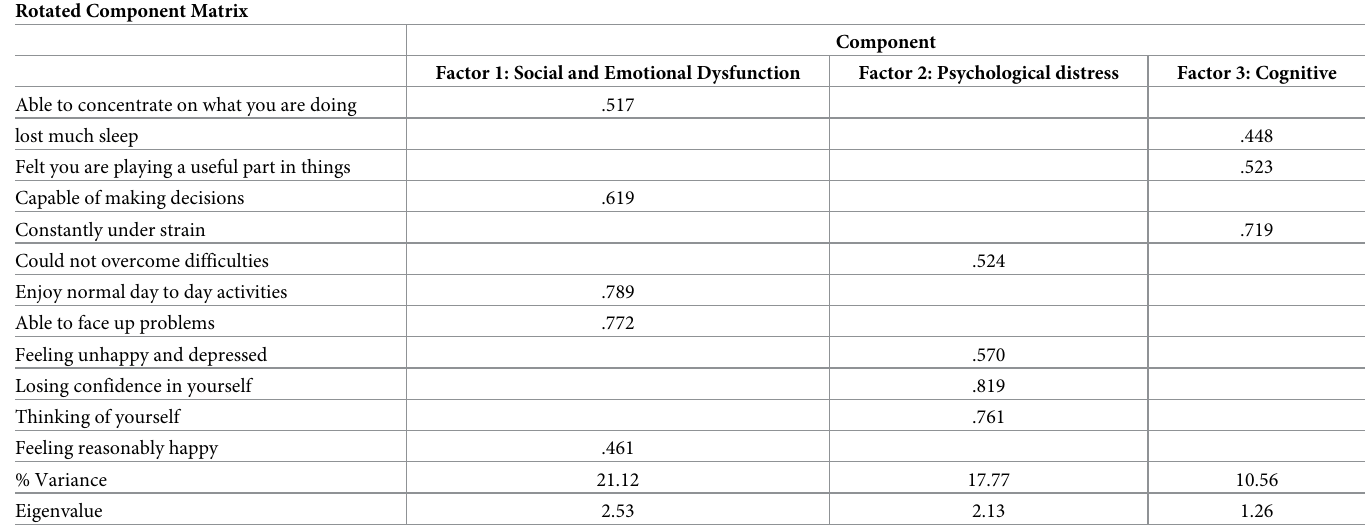
Table 6. The extracted components and factor loadings based on a principal components analysis with Varimax rotation for General Health Questionnaire